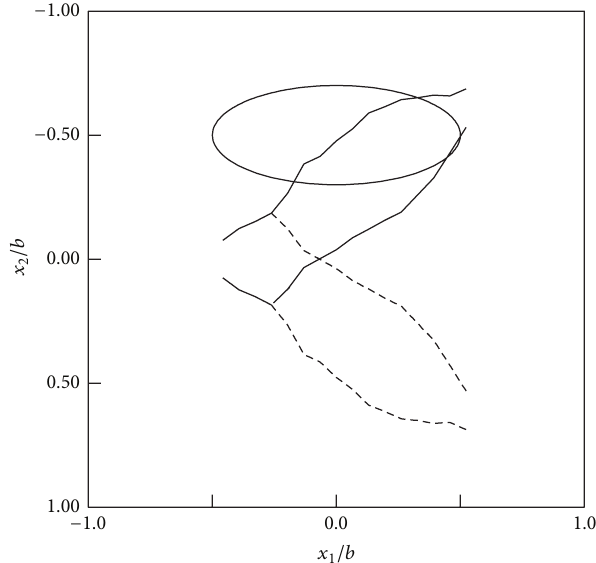
Figure 9: Reconstructed cavity with 𝑅 1 = 0.3𝑏 , 𝑅 2 = 0.2𝑏 , and ̃𝑥 2 = −0.5𝑏 .